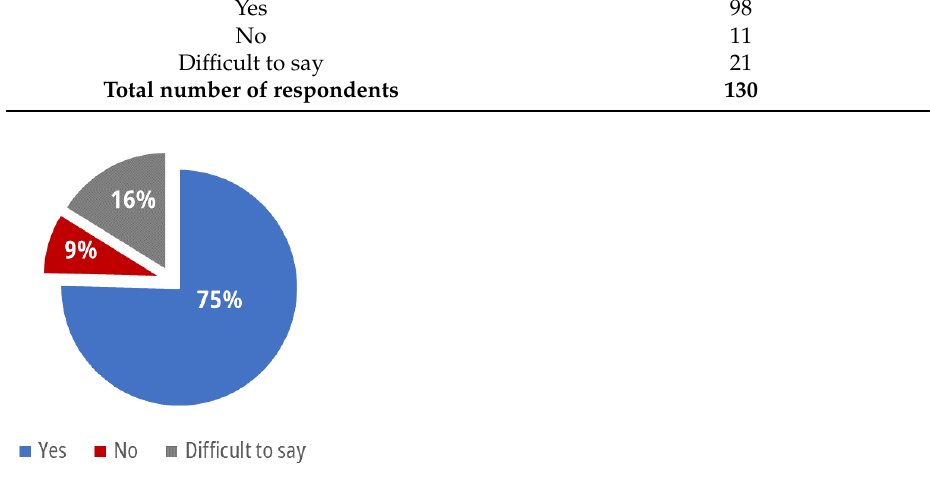
Figure A1. Responses to question (1).